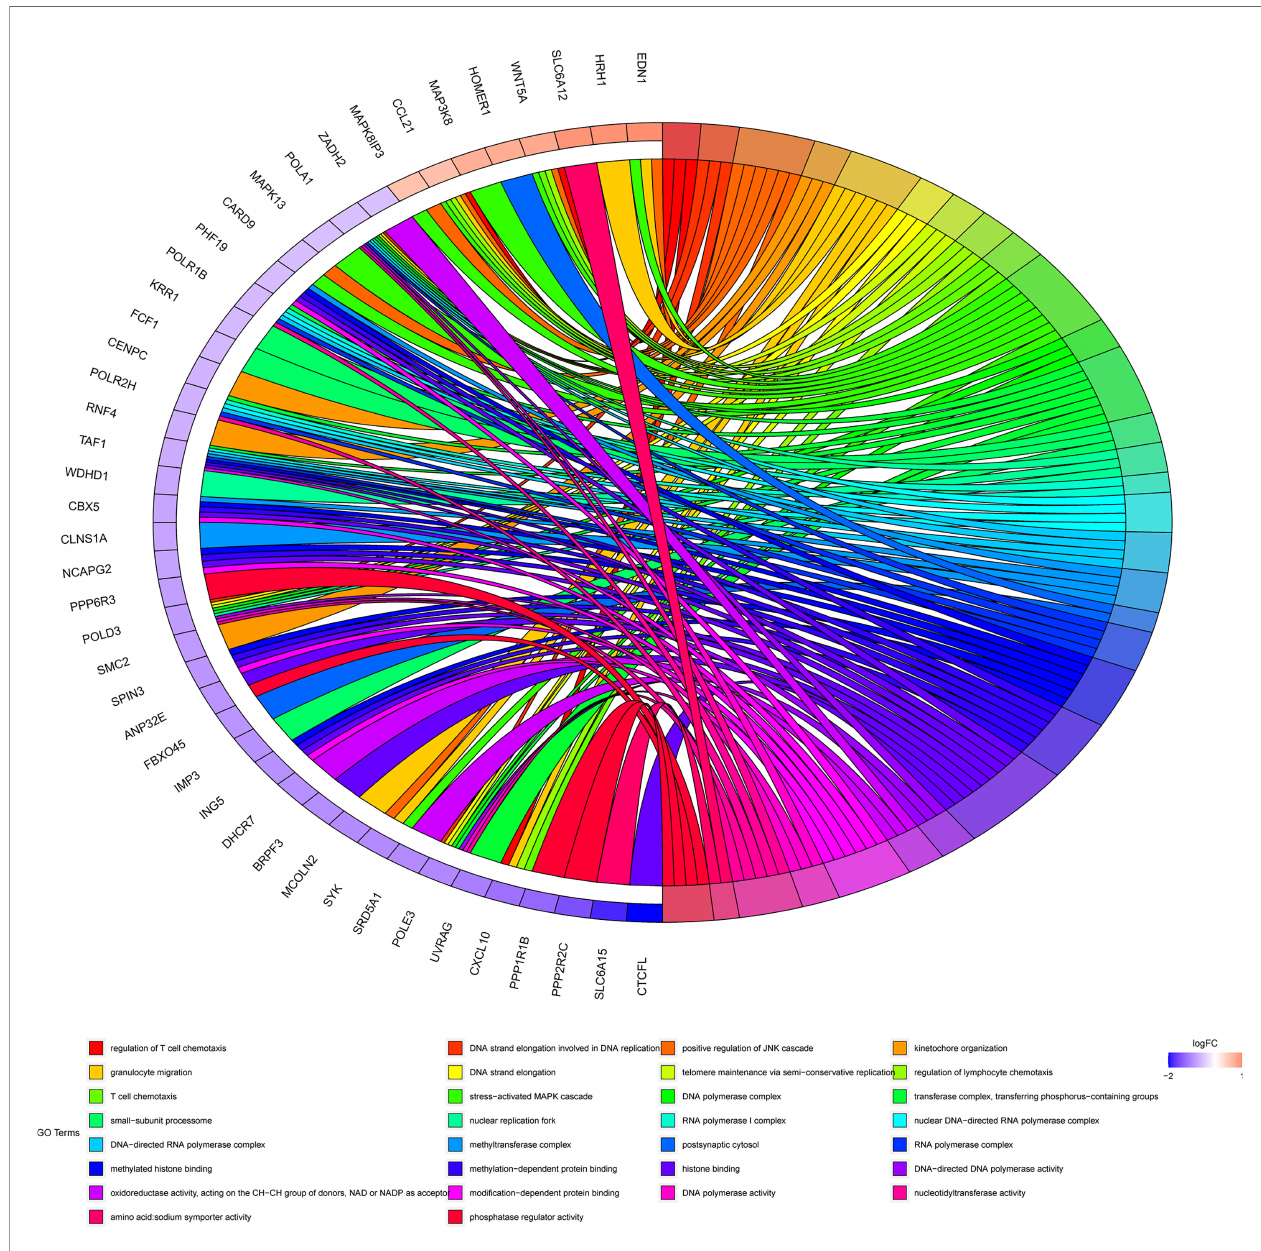
FIGURE 4 | Chord diagram of top 10 BP, CC, and MF. Different colors on the right of the chord diagram represent different GO terms, corresponding to legend, the left of the chord diagram represents mRNAs enriched in different GO terms, and the line in the middle represents mRNAs that are enriched in GO